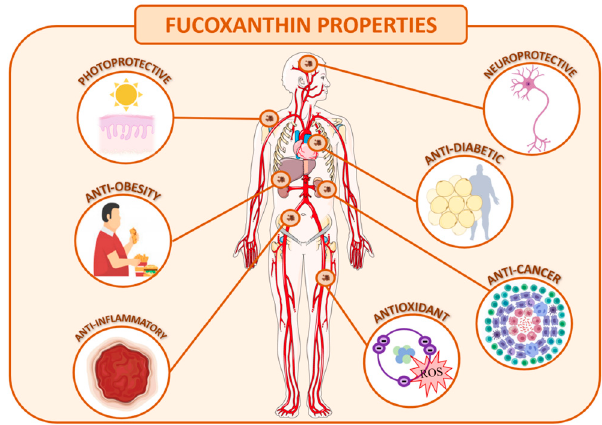
Figure 2. Human health benefits of fucoxanthin.